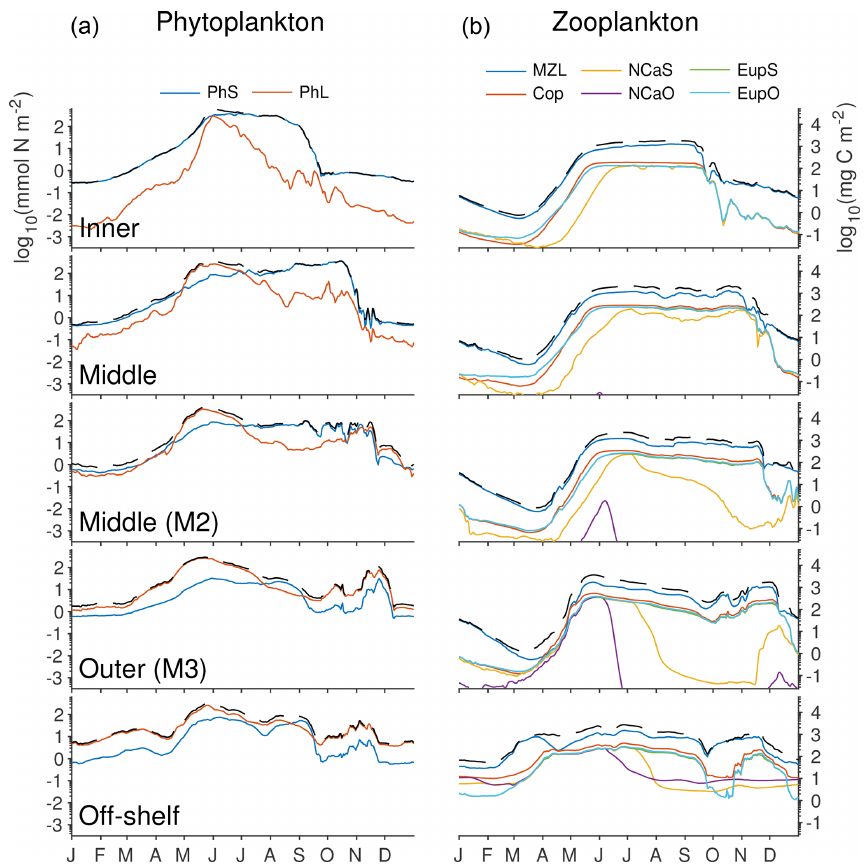
Figure 12. Depth-integrated biomass of phytoplankton and zooplankton groups in the southeastern Bering Sea shelf during the final year of the spinup simulation. Colors indicate the biomass value from each functional group, while the dashed black line indicates the total across all phytoplankton (a) or zooplankton (b) groups. Values were extracted from the model at the five locations indicated by gold dots in Fig. 1 (including the M2 mooring location). All axes use the same scale, labeled in nitrogen units on the left and carbon units on the